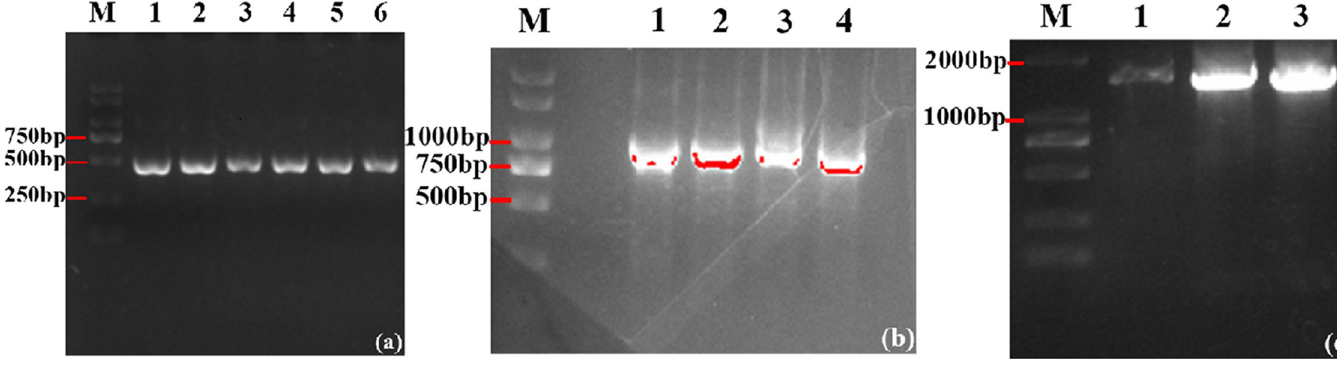
PLOS ONE | https://doi.org/10.1371/journal.pone.0277089 November29,